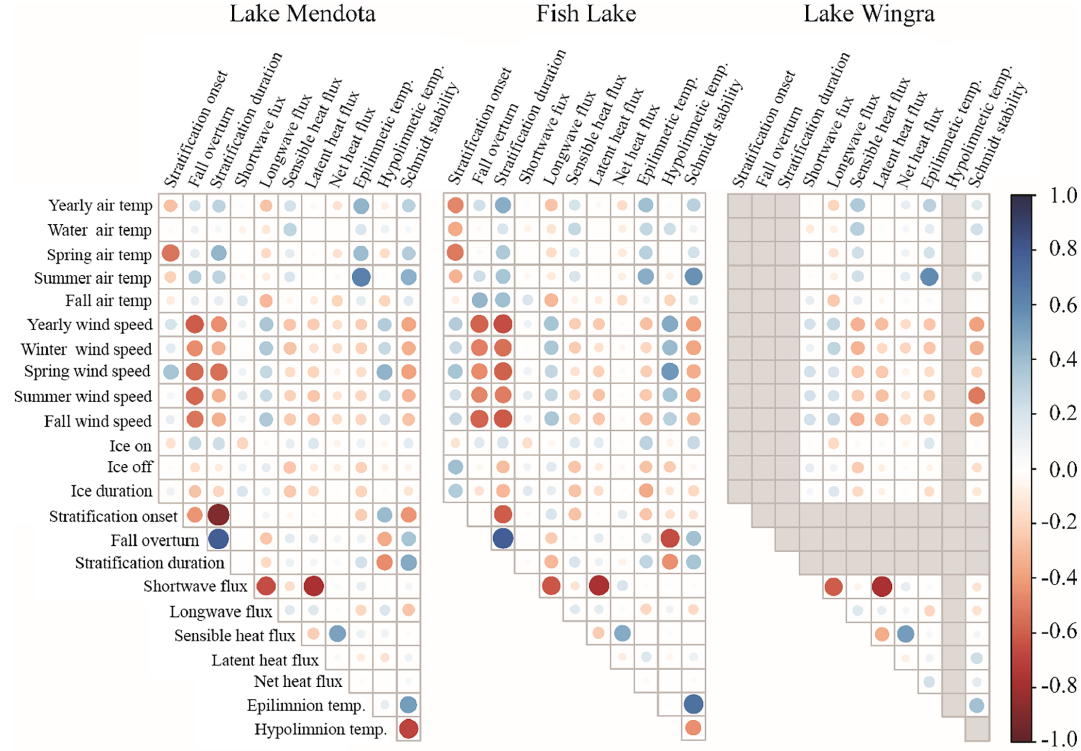
Figure 8. Plots of Pearson correlation coefficients among climate (air temperature and wind speed) variables and lake variables for the three study